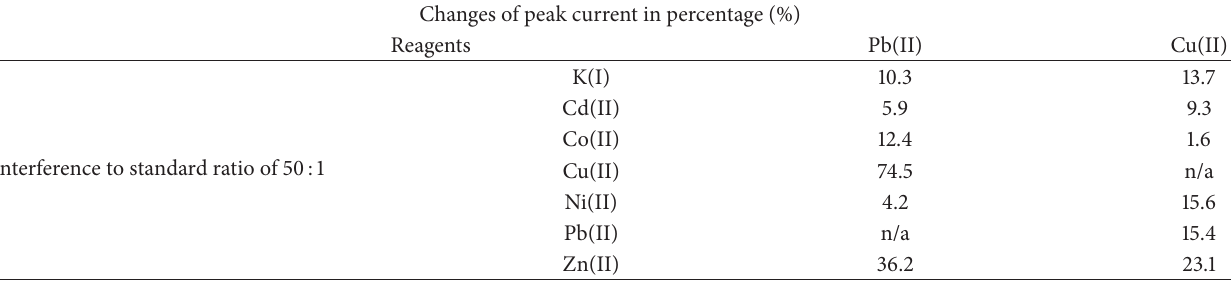
Table 2: Comparison of peak current generated by the standards versus interfering ions.